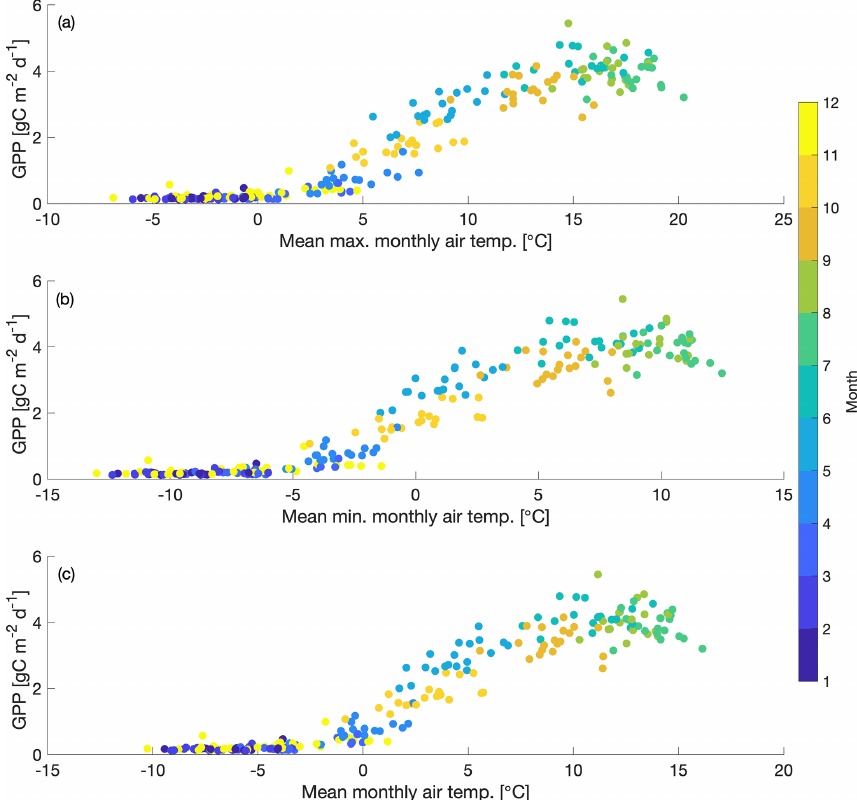
Figure 3. Scatterplot of mean monthly GPP vs. (a) mean maximum air temperature, (b) mean minimum air temperature and (c) mean air temperature for 2000–2018. Dots are colored with the corresponding